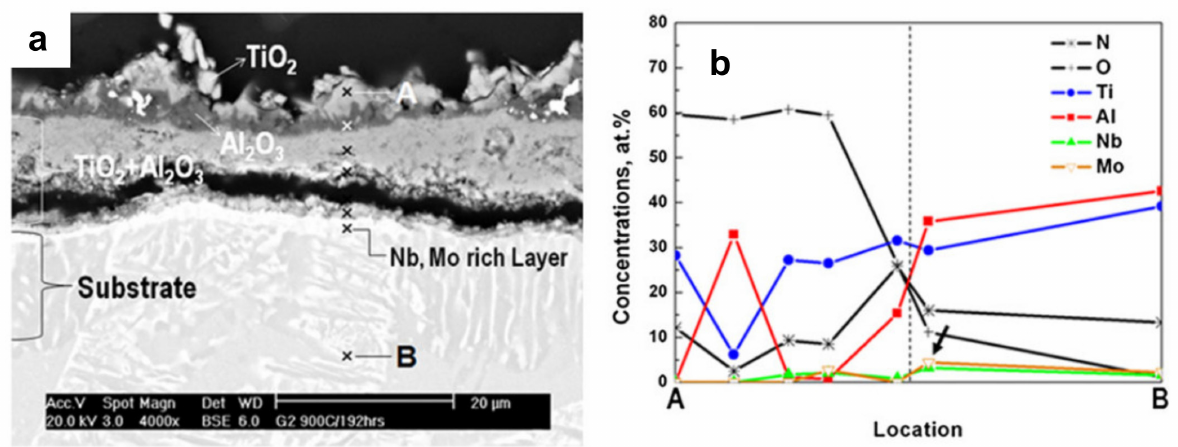
Figure 4. Element distribution on ( a ) the cross-section of oxide scales formed on isothermal exposed TiAl-2Nb-2Mo (G2) alloy at 900 ◦ C for up to 192 h and ( b ) dashed lines represent the location of interface between substrate and oxide layer. Reprinted from Intermetallics, 19, DJ Kim, DY Seo, H Saari, T Sawatzky, Y-W Kim, Isothermal oxidation behavior of